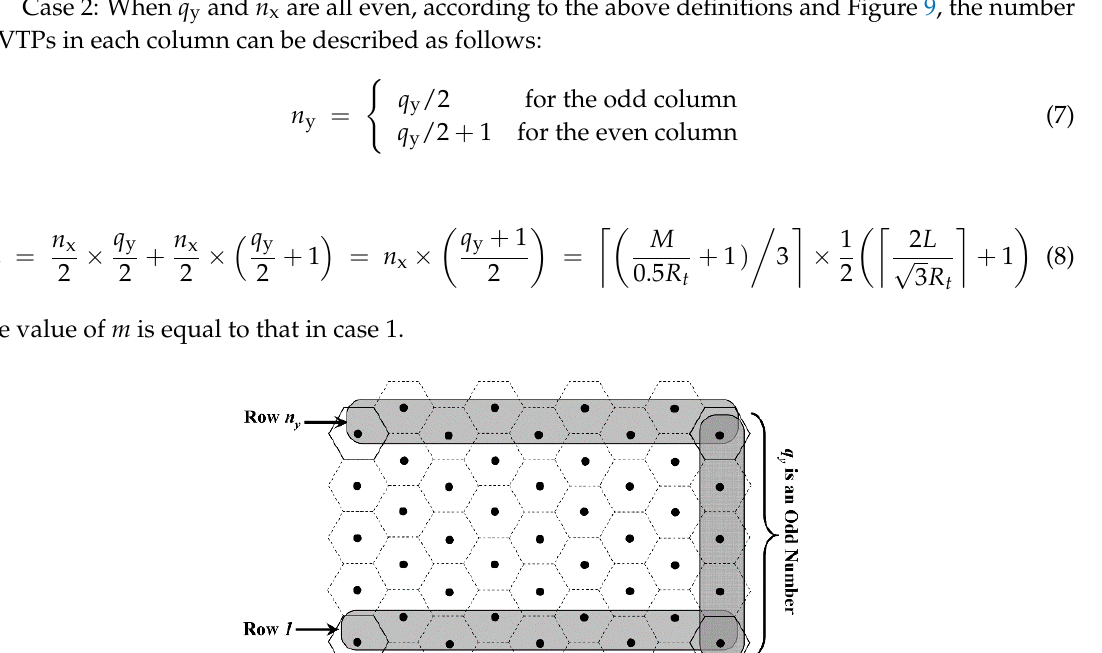
Figure 8. Distribution of VTPs when q y is odd.